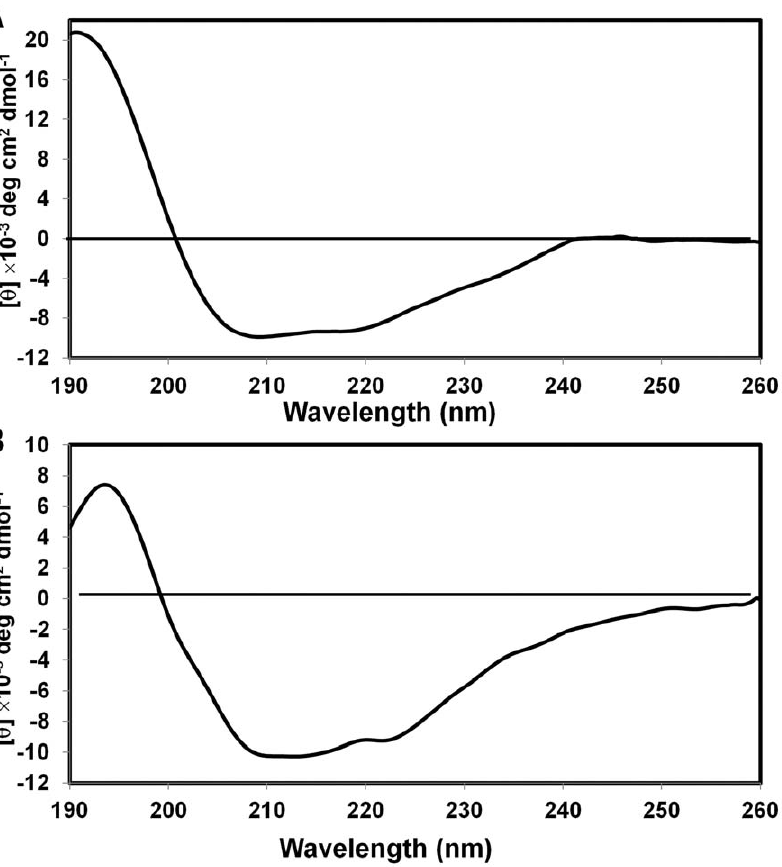
Figure 1. CD analysis of Bcl-2. The purified Bcl-2 was concentrated to 1 mg/ml and exchanged to the phosphate buffer containing 20 Na-PO 4 , pH 7.4, 100 mM NaCl, and subject to CD analysis of Bcl-2 (A) and pBcl-2 (B).